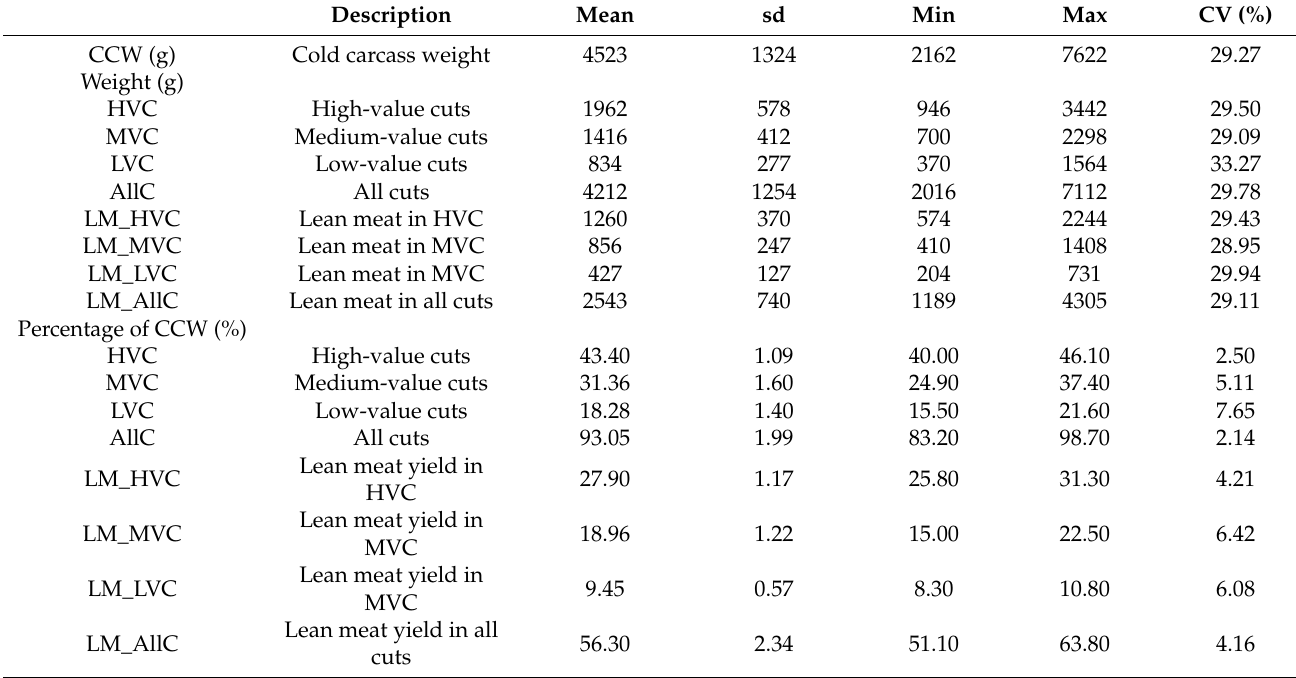
Table 1. Mean, standard deviation (sd), minimum (min), maximum (max) and coefficient of variation (CV) of weight and yield of groups of commercial-value cuts of lamb